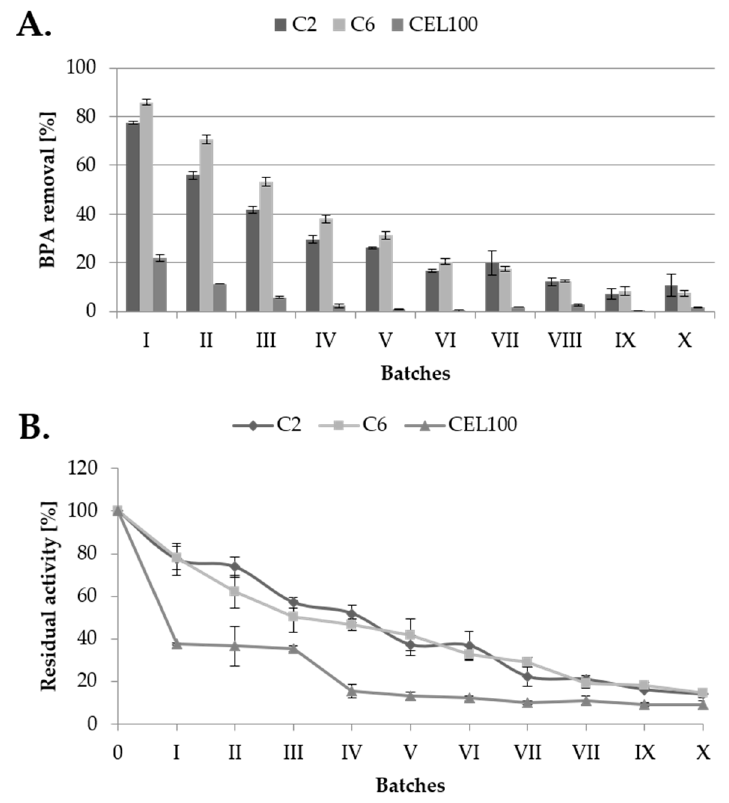
Figure 10. Rate of bisphenol A transformation during ten subsequent batches ( A ) and residual LAC activity ( B ) measured on the tested C2, C6 and CEL100 carriers.